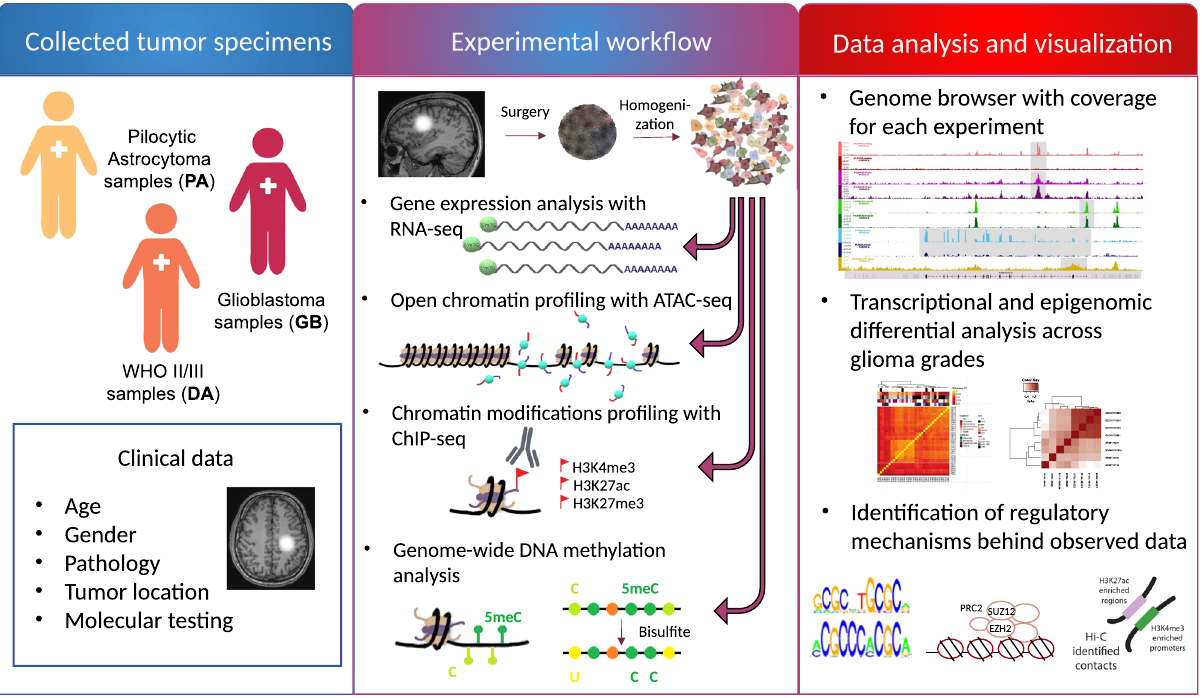
Fig. 1 Experimental work fl ow. Freshly resected glioma specimens were acquired from patients representing major glioma malignancy groups: pilocytic astrocytomas (WHO grade I, PA, n = 11), diffuse astrocytomas (WHO grade II and III, DA, n = 7) and glioblastomas (WHO grade IV, GBM, n = 15). Clinical data about each patient was collected. Glioma tissues were homogenized to a single cell suspension and experimentally de fi ned numbers of cells were split into portions that were processed for RNA-seq, ATAC-seq, ChIP-seq, or DNA methylation experiments. Differential analysis of epigenomic and transciptomic pro fi les across glioma grades was performed, followed by identi fi cation of related regulatory mechanisms. Results from all genome-wide experiments were made available in a genome browser